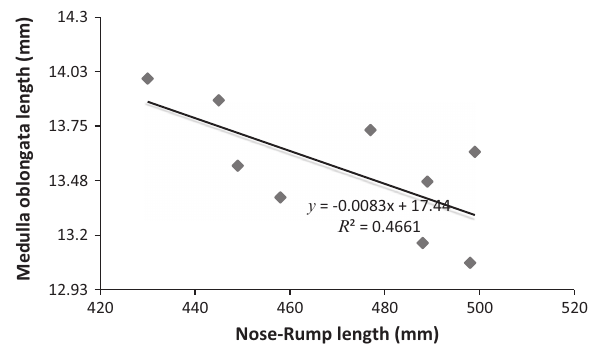
FIGURE 2: Negative linear relationship between nose-rump and medulla oblongata lengths in the African grasscutter on postnatal day 450.